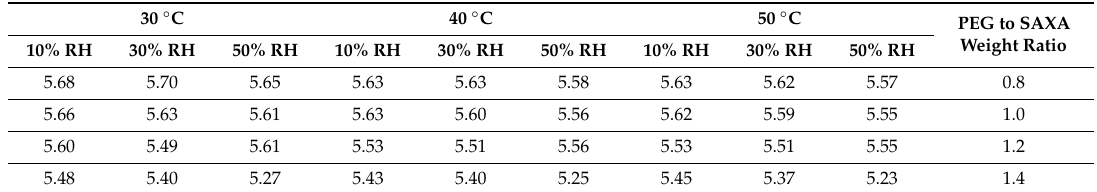
Figure 3. Polyethylene glycol (PEG) degradation profile. Concentration of main PEG degradation products: glycolic acid (GA), acetaldehyde (A), formaldehyde (F) and formic acid (FA) are graphed on y axis (ppm against tablet film-coat; w/w ), and time is graphed on x axis (days). Table 3. Averaged results of pH measurements for different compositions at temperatures of 30 to 50 °C and nominal water activities 10% to 50%.